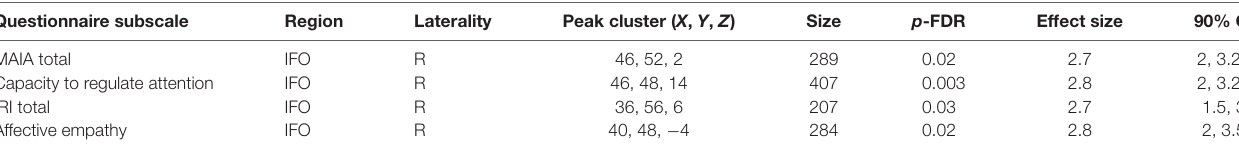
FIGURE 2 | Greater connectivity in the right inferior frontal operculum (rIFO) is associated with lower total IA and greater Affective empathy. Statistical maps are FDR-corrected within the network at cluster-based p < 0.05, after voxel threshold at p < 0.001, and further corrected for age, gender, and multiple comparisons across components using FDR. TABLE 3 | Network connectivity